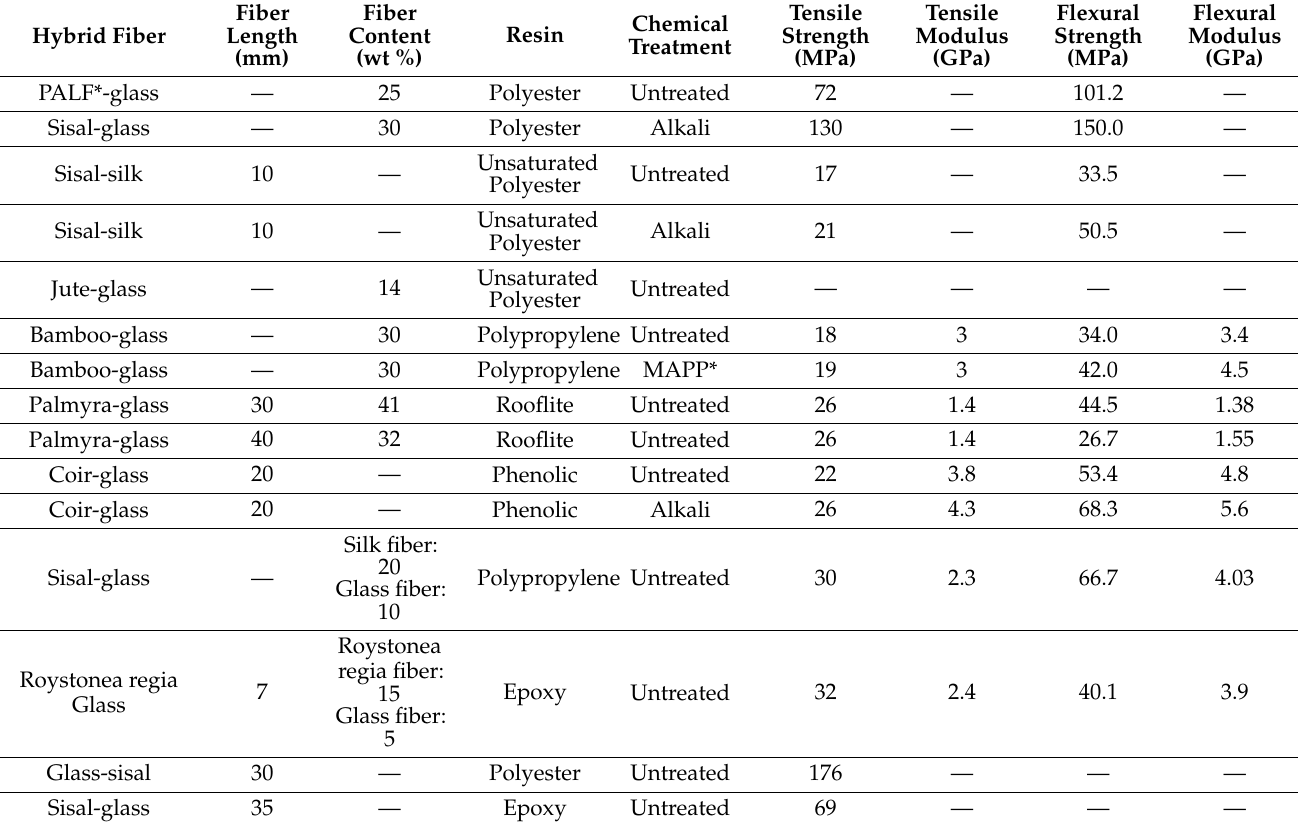
Table 1. Mechanical properties of hybrid composites